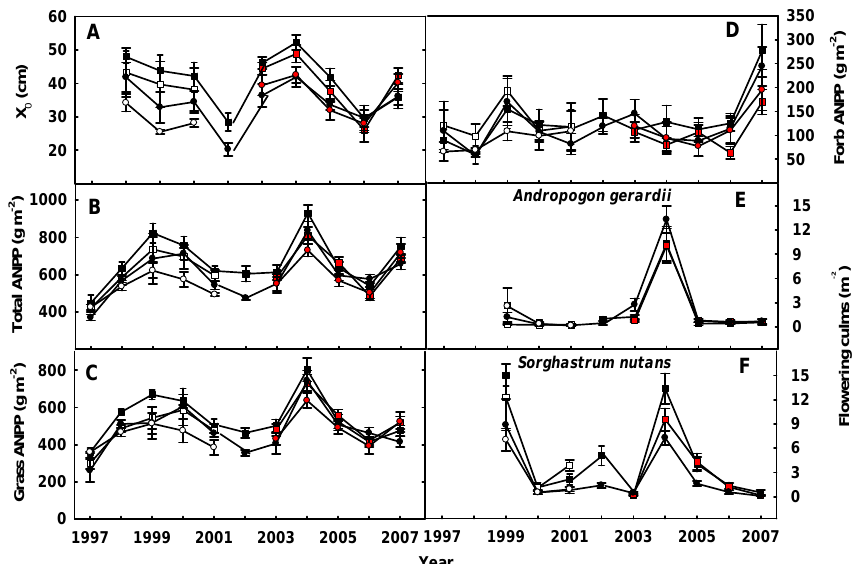
Fig. 5. Plant growth by year in the rainfall pattern and warming treatments, error bars denote 1SE. Symbols as in Fig. 1. (A) Canopy light interception ( x 0 ), the height in the canopy receiving 50% of incoming light, a proxy for aboveground biomass. (B) Total, (C) grass and (D) forb ANPP. Flowering culm production in the dominant C 4 grasses (E) Andropogon gerardii and (F) Sorghastrum nutans .